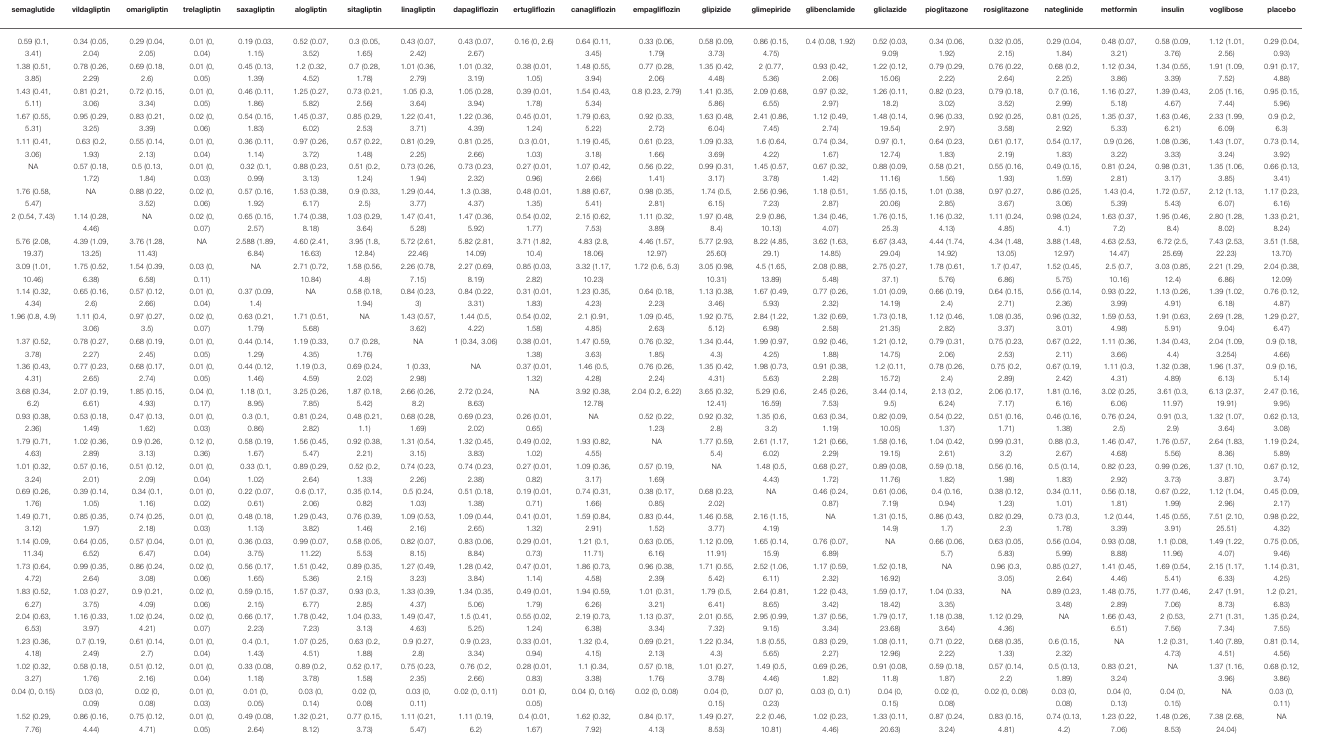
TABLE 1 | Estimated relative treatment effects as risk ratios (RRs) and its corresponding 95% con fi dence intervals (CIs). Treatment albiglutide dulaglutide exenatide lixisenatide liraglutide semaglutide vildagliptin omarigliptin trelagliptin saxagliptin alogliptin sitagliptin linagliptin dapagli fl ozin ertugli fl ozin canagli fl ozin empagli fl ozin glipizide glimepiride glibenclamide gliclazide pioglitazone rosiglitazone nateglinide metformin insulin voglibose placebo